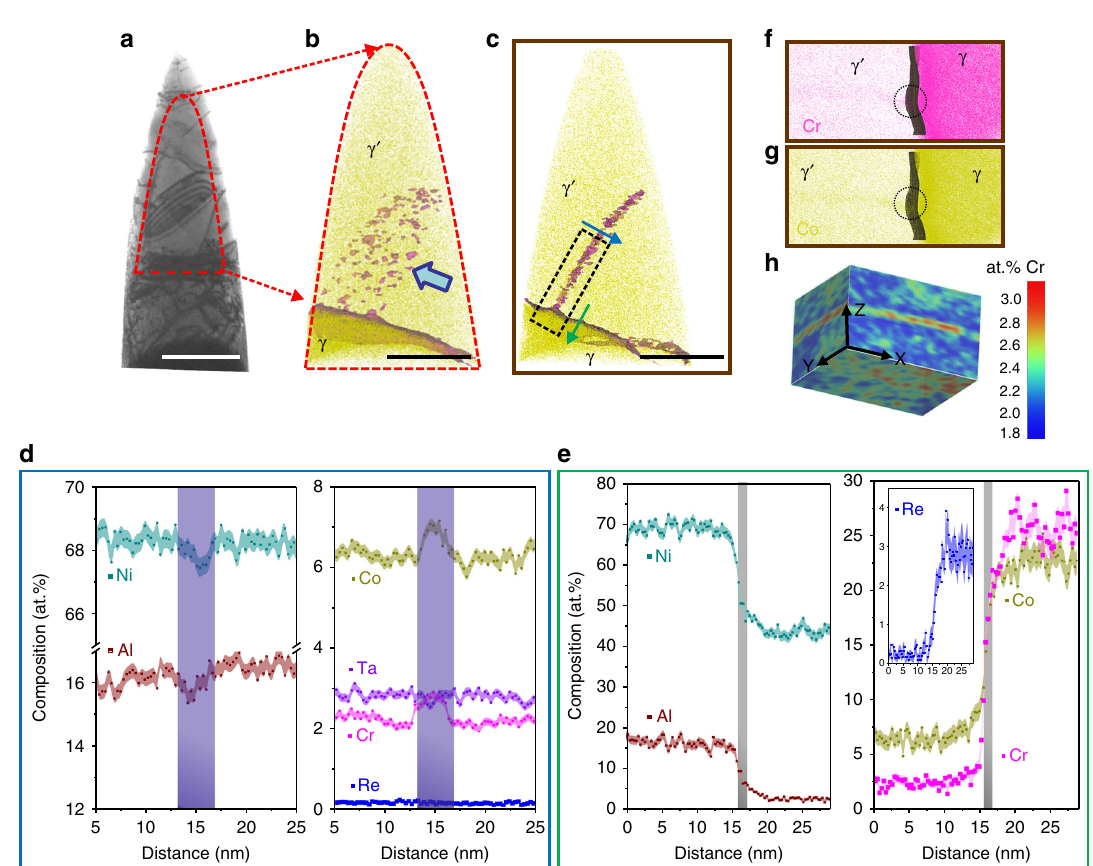
Fig. 3 Correlative TEM/APT investigation showing a SF from the 1% crept sample. a TEM BF showing the contrast of a SF. b Corresponding APT reconstruction showing a γ / γ ′ interface and a SF (highlighted by magenta, 3.4 at% Cr iso-composition surfaces) in the γ ′ . c SF viewed edge-on, indicating the SF is connecting with a trailing partial dislocation in the groove. Two arrows (blue: perpendicular to the SF plane and green: across γ / γ ′ interface through the partial dislocation in the groove) show two directions of compositional analysis, the rectangle highlights the fault region. 1D compositional analysis as shown in the two directions: d along blue arrow: perpendicular to the fault plane, the light purple rectangle highlights the fault region, and e along green arrow: across γ / γ ′ interface through the partial dislocation in the groove, and the light grey rectangle shows the γ / γ ′ interface. f Cr atoms displaying γ & γ ′ phases and the SF. g Co surface displaying γ & γ ′ and the SF and h 2D projection in XZ and YZ plane highlighting the fault region. Size of region of interest: 24 × 12 × 100 nm 3 . Scale bar: a 500 nm; b , c 50 nm. The error bars in Fig. 3d, e are estimated as described in Methods